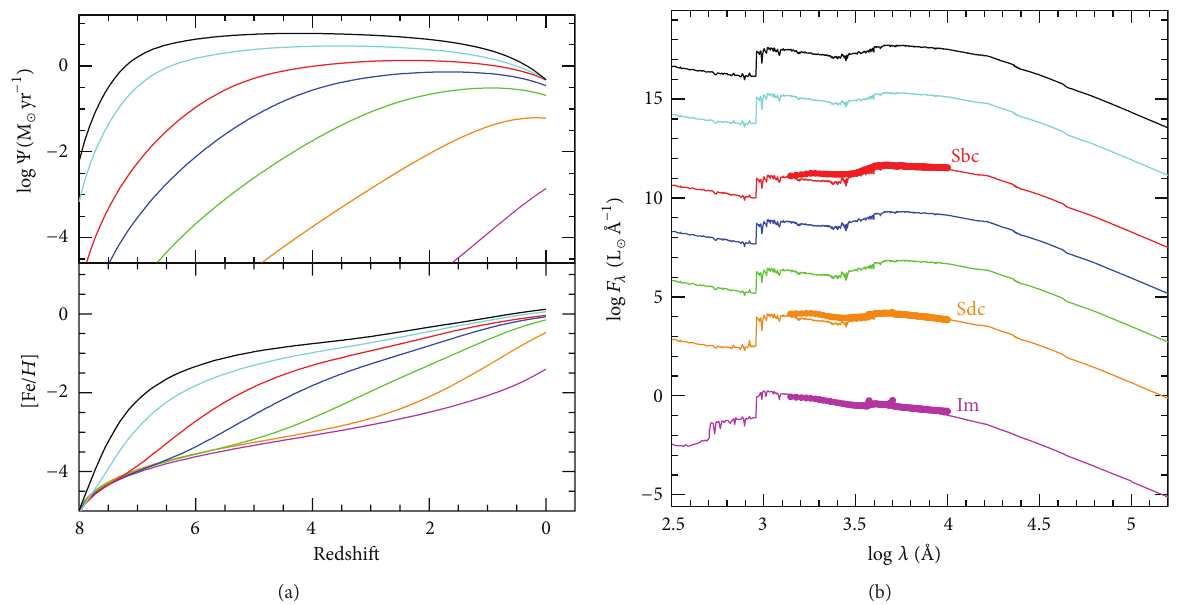
Figure 9: (a) The star formation Ψ(𝑡) and iron enrichment [Fe/ 𝐻 ] (𝑡) evolution with redshift 𝑧 for the radial regions located at 𝑅 𝑐 of models of Table 1. (b) The resulting spectral energy distributions, 𝐹 𝜆 (𝜆,𝑡 = 13.2 Gyr ) obtained for the same radial region and galaxy model compared with the fiducial templates from Coleman et al. [106].